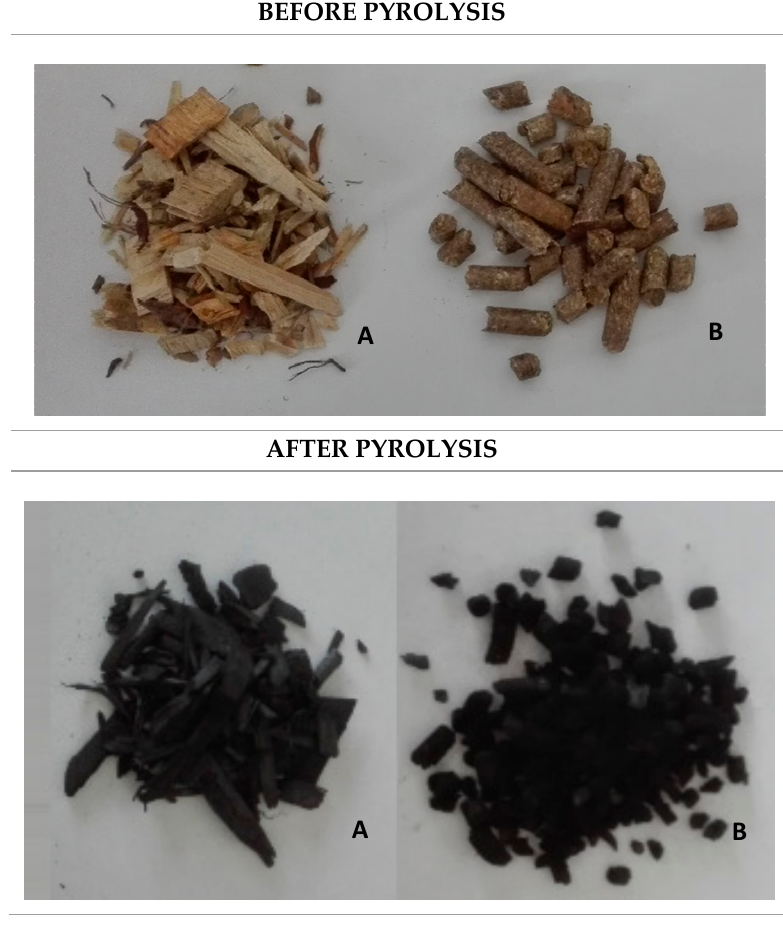
Figure 1. Raw materials before and after pyrolysis: ( A ) beech wood chips; and ( B ) straw pellets.